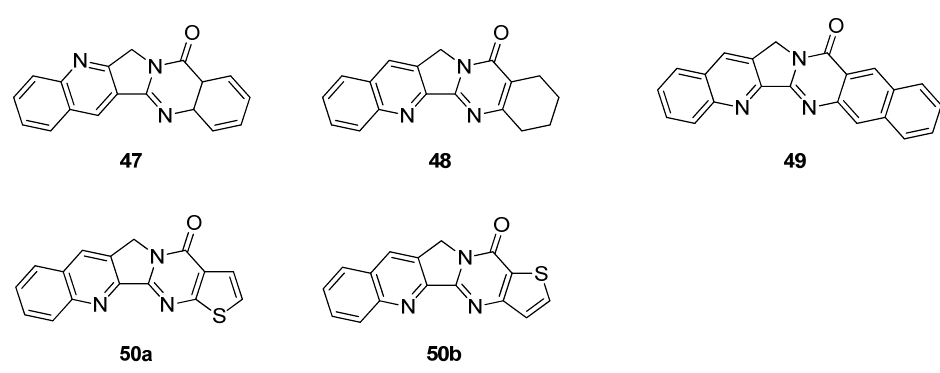
Figure 2. Isosteres of luotonin